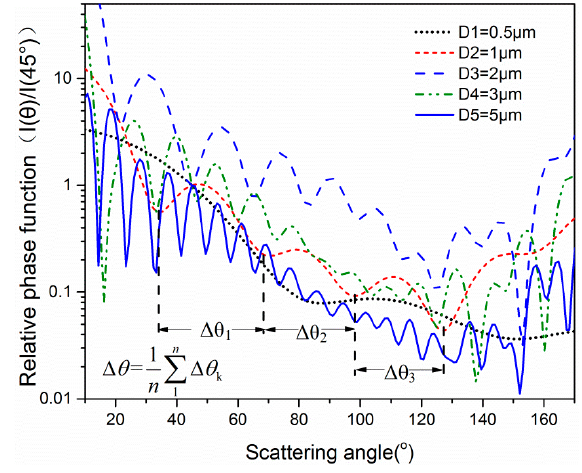
Figure 1. The calculated relative phase function I( θ )/I(45°) for different quartz particle sizes.